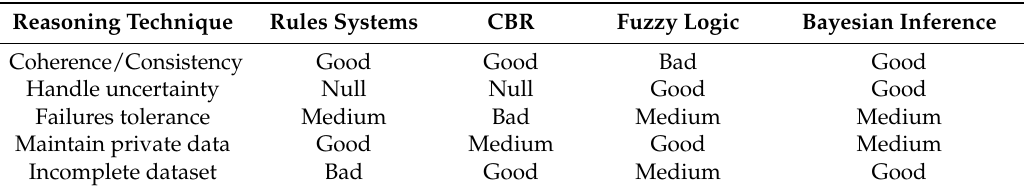
Table 1. Reasoning